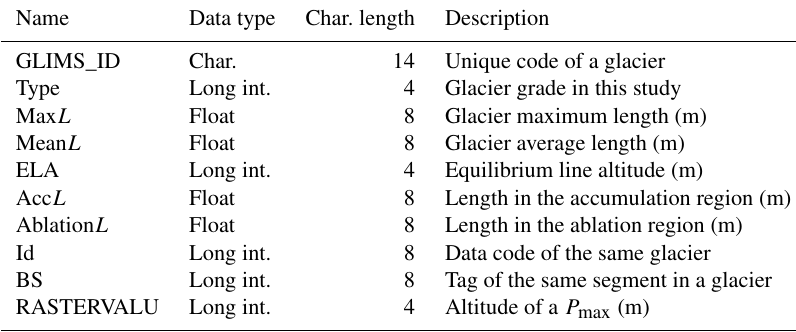
Table 4. Description of the attributes contained in all datasets.